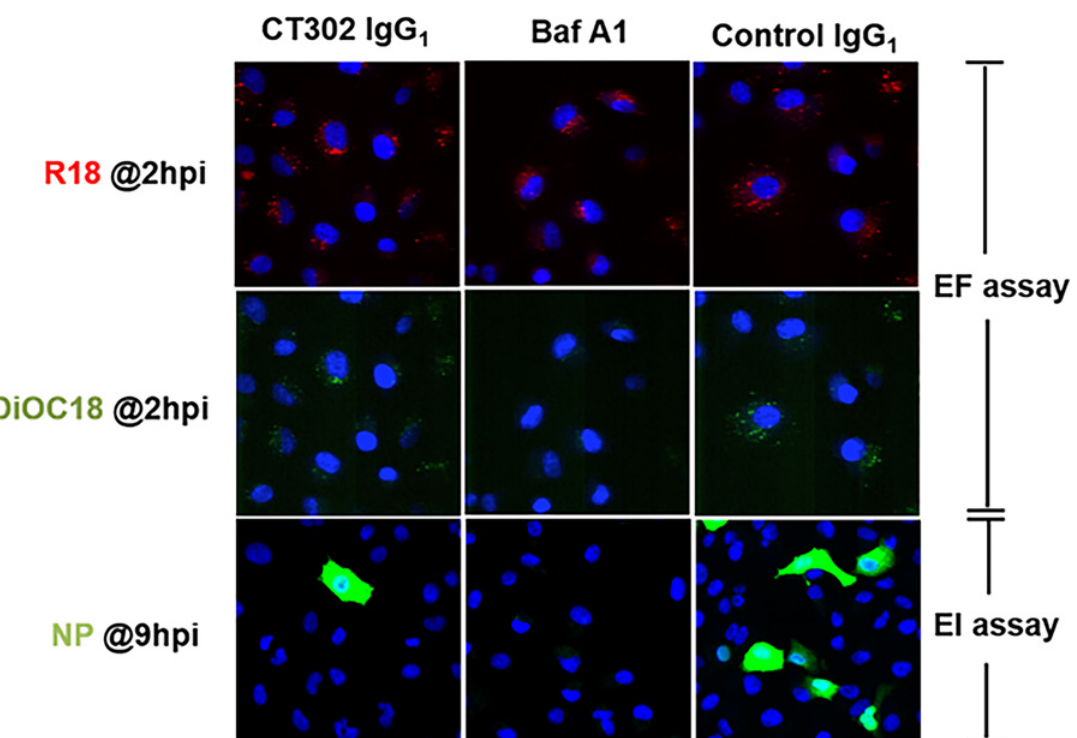
Fig 3. Effect of CT302 IgG 1 on the membrane fusion and the traffic of viral nucleoprotein to nucleus. Entry fusion (EF) assay: Virus particles were labeled with DiOC18 and R18, and were allowed to enter CT302 IgG1-, Bafilomycin A1- or control IgG1-treated cells. Fusion of viral and vacuolar membranes of cells triggered dequenching of DiOC18 (green) signal co-localized with the R18 (Red) signal. Nuclear import (EI assay): In the CT302 IgG 1 -, BafilomycinA1- or control IgG 1 -treated cells, virus particles were allowed to enter nucleus. Incoming NP proteins (green) were detected within the nucleus (blue) by the anti-NP antibody. Magnification: